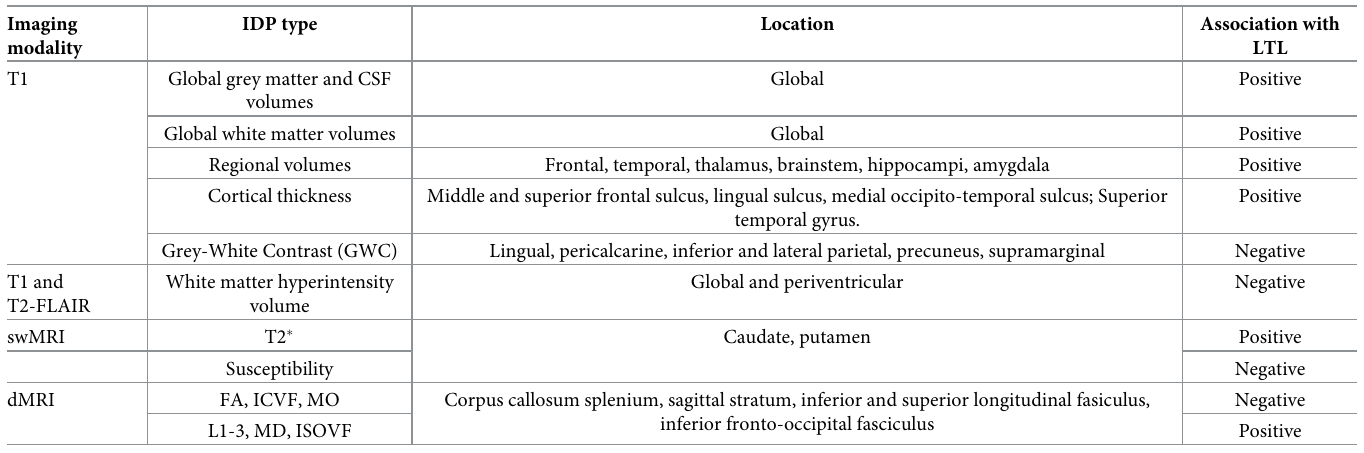
Table 1. Summary of individual image-derived phenotype associations with leucocyte telomere